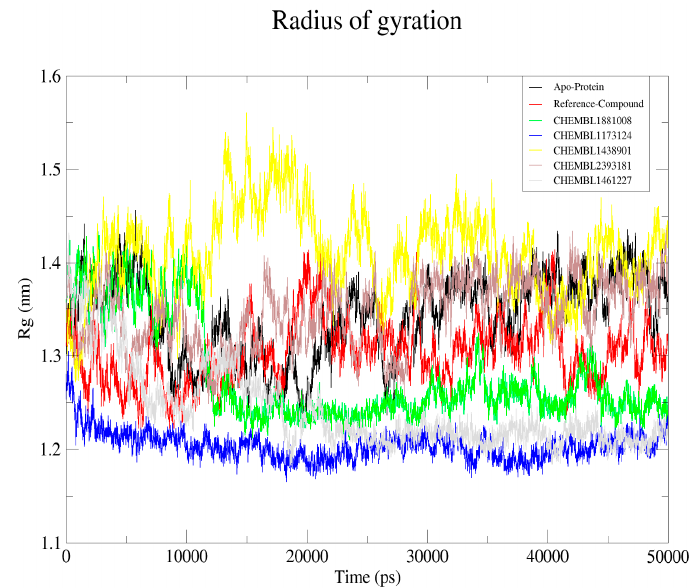
Figure 6. The Radius of Gyration Graph of all complexes along with apo-protein during 50 ns MD Simulation.